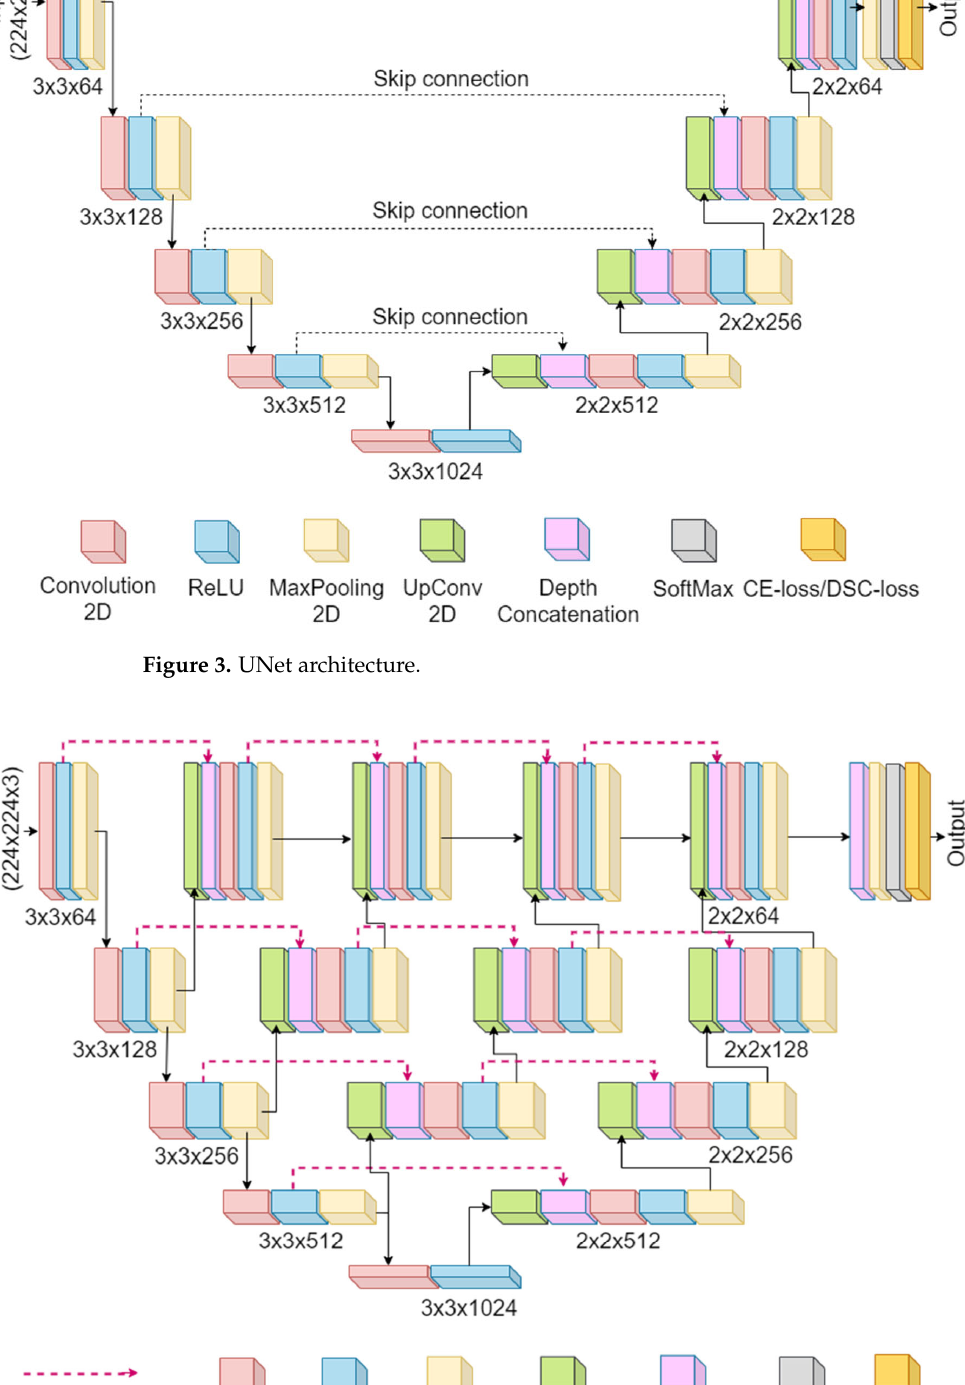
Cross ‐ validation: A total of 704 CXR images and their 704 corresponding masks were used for the segmentation experiment. The K5 data partitioning method was imple ‐ mented. The 5 ‐ fold cross ‐ validation is the most popular protocol, where 80% of images are used for training and 20% for testing the model [51,52]. The cross ‐ validation technique is most useful if the number of available images for training and testing is low. In the small size, dataset cross ‐ validation enables the utilization of each image for training and each image for testing at least once. This prevents a high error in the results; therefore, the most reliable results could be achieved. Our segmentation dataset has 704 images that are also relatively low in numbers, which is why using cross ‐ validation enables our results to be more reliable. The 5 ‐ fold cross ‐ validation was performed utilizing 80% of images for the training part (60%, i.e., 408 images for training, and 20%, i.e., 148 images for validation). The 20%, i.e., 148 images were utilized for testing the model in each fold. After each fold’s training and validation, testing was performed on 148 new images that were not used in training or validation. The average test results for each fold were calculated to obtain the performance analysis, including the test accuracy and loss. In addition, the mask was gen ‐ erated for images of the test set using each model developed by training on each fold’s images. Next, all of the predicted masks from each fold’s test images were compared with their ground truth masks to see how well they worked. This was done by generating the Dice, Jaccard, area error, Bland–Altman plot, coefficient of correlation, and receiver oper ‐ ating characteristics (ROC).